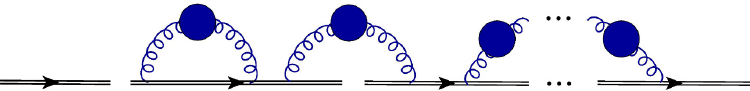
Figure 7. A boomerang Cweb constructed out of n two point correlators connecting n Wilson lines, derived from one of the basis Cwebs at O ( α n